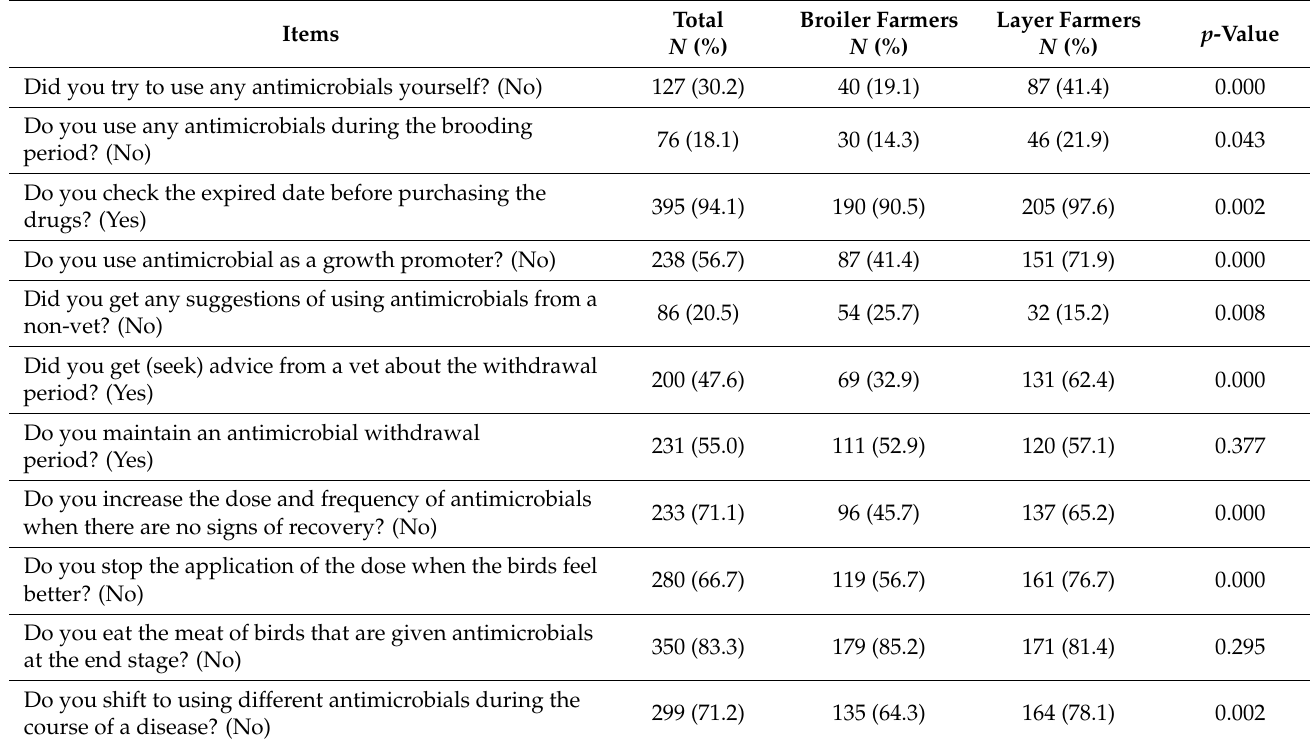
Table 4. Practices in AMU and AMR in broiler and layer